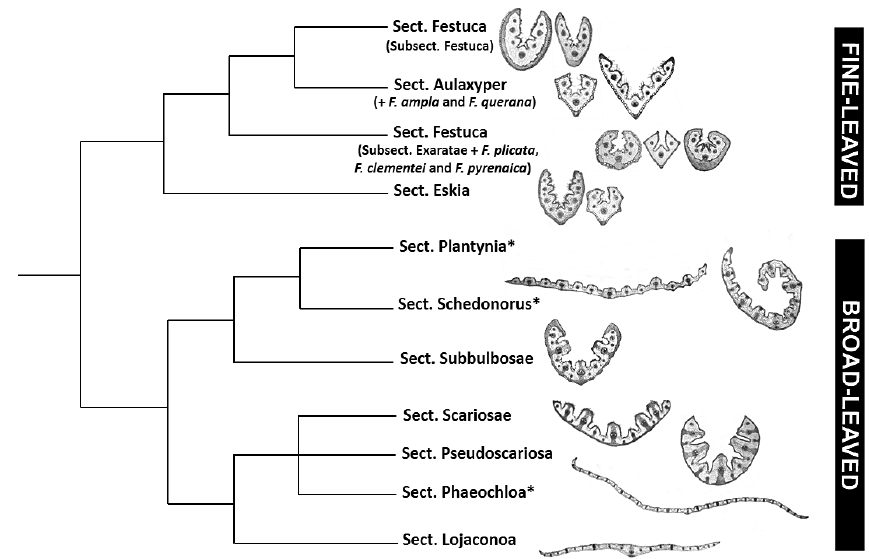
Figure 3. Simplified cladogram showing the major supraspecific relations in Festuca s.str., based and adapted on phylogenetic trees from Catalán et al. (2004), and Inda et al. (2008). Main leaf anatomical patterns are exemplified in each line evolutive. Abbreviations: L1, lineage 1; L2, lineage 2; and L3, lineage 3. Asterisks indicate sections which have been included in other subgenera by several authors (sect. Pha- eochloa in the subgenus Drymanthele , and sects. Schedonorus and Plantynia in the subgenus Schedonorus